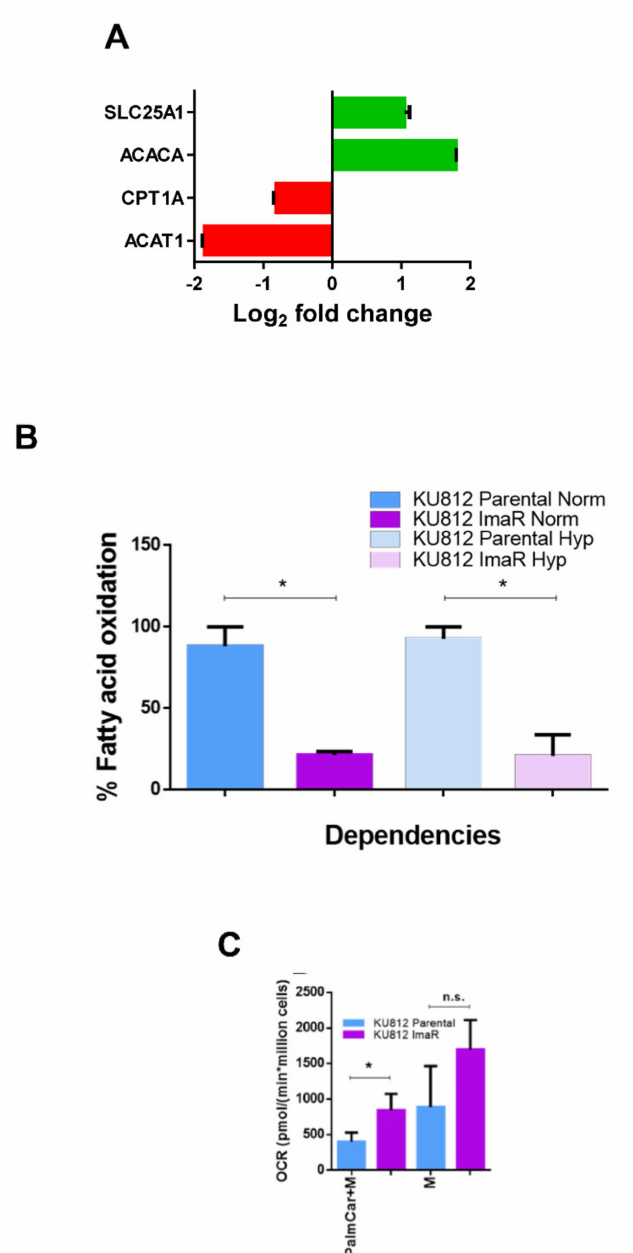
Figure 7. Acquisition of imatinib resistance alters the fatty acid metabolism of KU812 cells. ( A ) Protein profiling di ff erences of KU812 imatinib-resistant (ImaR) cells when compared to KU812 Parental cells regarding fatty acid metabolism. The protein expression profiling was obtained using SILAC-based proteomic experiments. Log2 fold change values were calculated and represented by green color = protein upregulation; and red = protein downregulation. Data are provided as mean ± SD of n = 2. ( B ) Fatty acid contribution to mitochondrial respiration using Mitofuel Flex Test results of KU812 Parental and ImaR cells under normoxia (Norm) and hypoxia (Hyp). All the results were calculated as explained in Materials and Methods. The figure shows the mean ± SD for n = 3. ( C ) Oxygen consumption rate (OCR) measurements of permeabilized KU812 Parental and ImaR cells in normoxia when adding fatty acids (PalmCar, palmitoyl-DL-carnitine-HCl) plus 0.1 mM malate (M). Significance was determined by two-tailed independent sample Student’s t -test. Statistically significant di ff erences between KU812 Parental and KU812 ImaR cells were indicated as * p < 0.05 and p ≥ 0.05 (n.s. = non-significant di ff erences). Abbreviations: ACACA, acetyl-CoA carboxylase alpha;